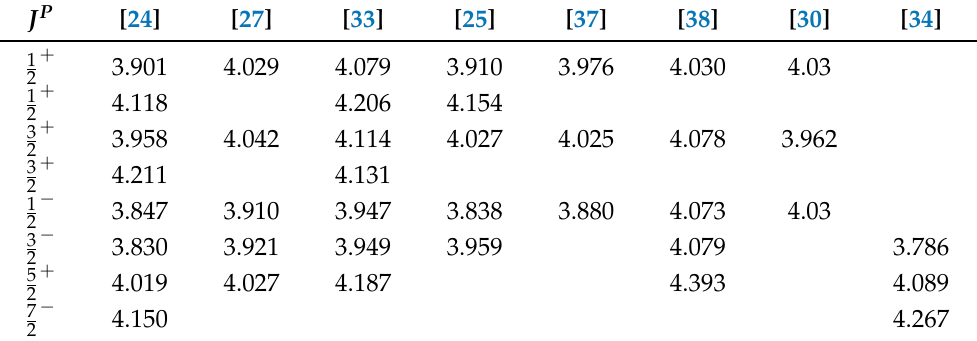
Table 1. Excited state masses by various theoretical approaches (in GeV).